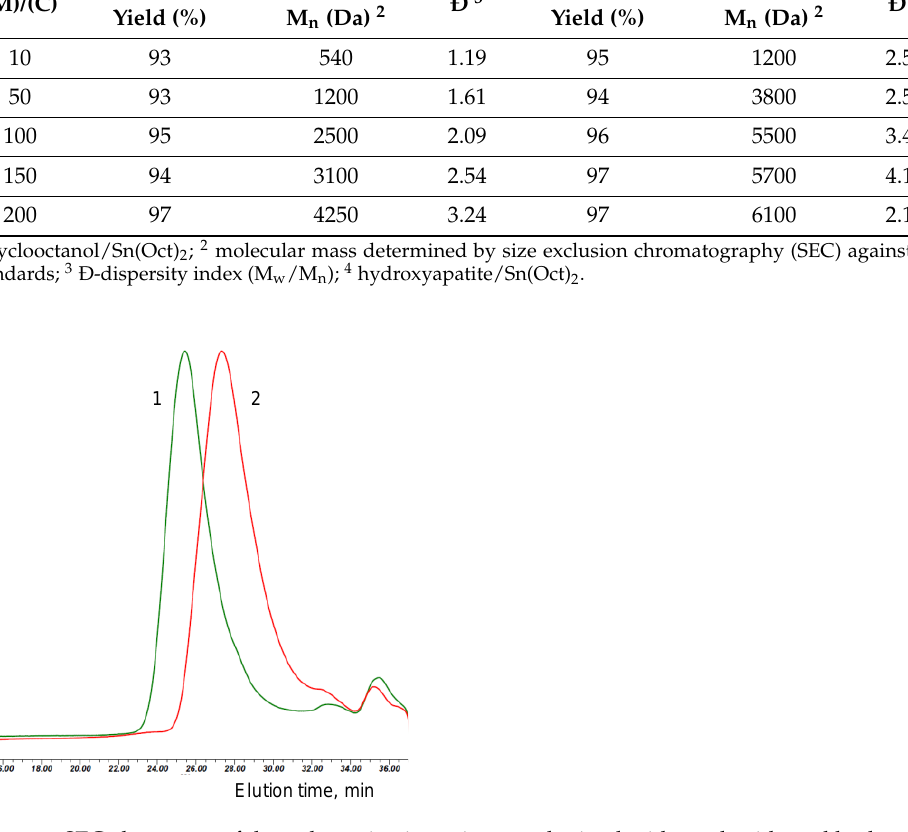
Figure 1. SEC eluograms of the polymerization mixtures obtained with D , L -lactide and hydroxyap- atite (HA)/Sn(Oct) 2 (green trace, 1) and Cyclooctanol/Sn(Oct) 2 (red trace, 2) with (M)/(C) =